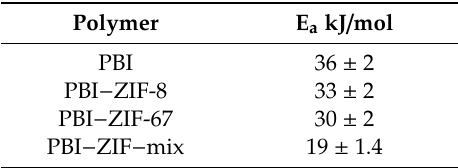
Table 5. Activation energies for the PBI composite membranes along the temperature interval 20–90 °C. ZIF, zeolitic imidazolate framework.